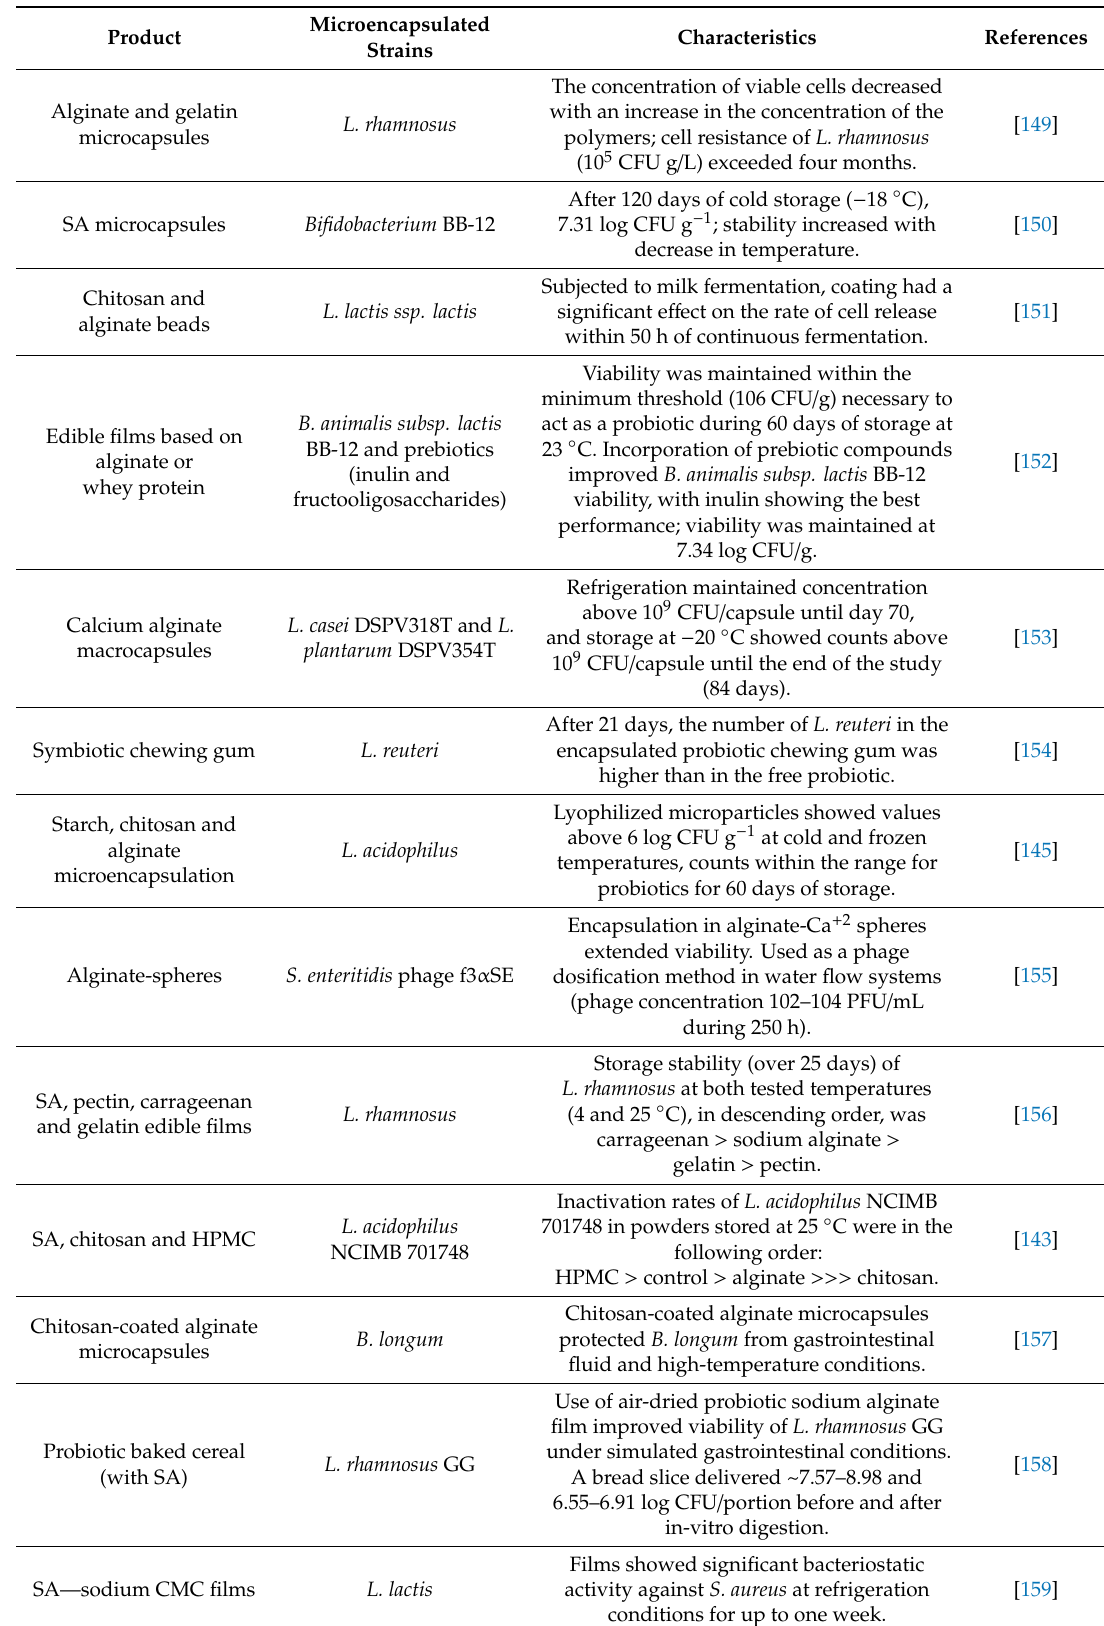
Table 3. Probiotic strains encapsulated with